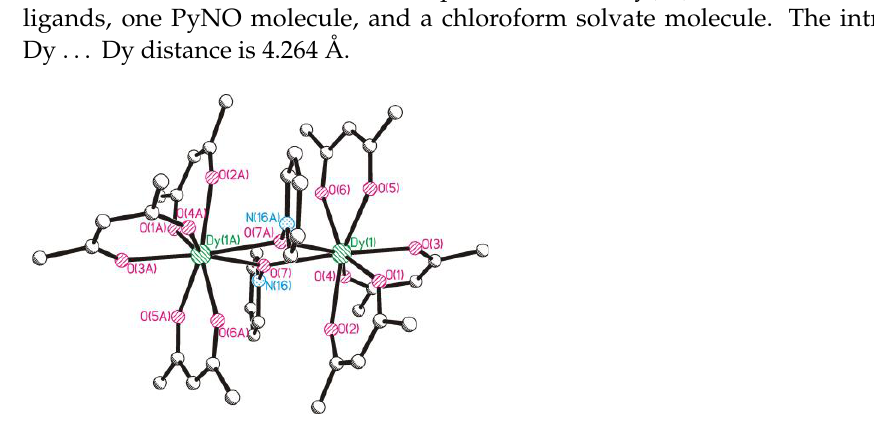
Figure 1. Molecular structure of 1 . The hydrogen atoms are not shown for clarity, the carbon atoms are not marked. Color code: green – Dy; blue – nitrogen; red – oxygen; grey – carbon. Atoms labeled with the letter A are generated by the symmetry code (1—x, —y, 2—z).